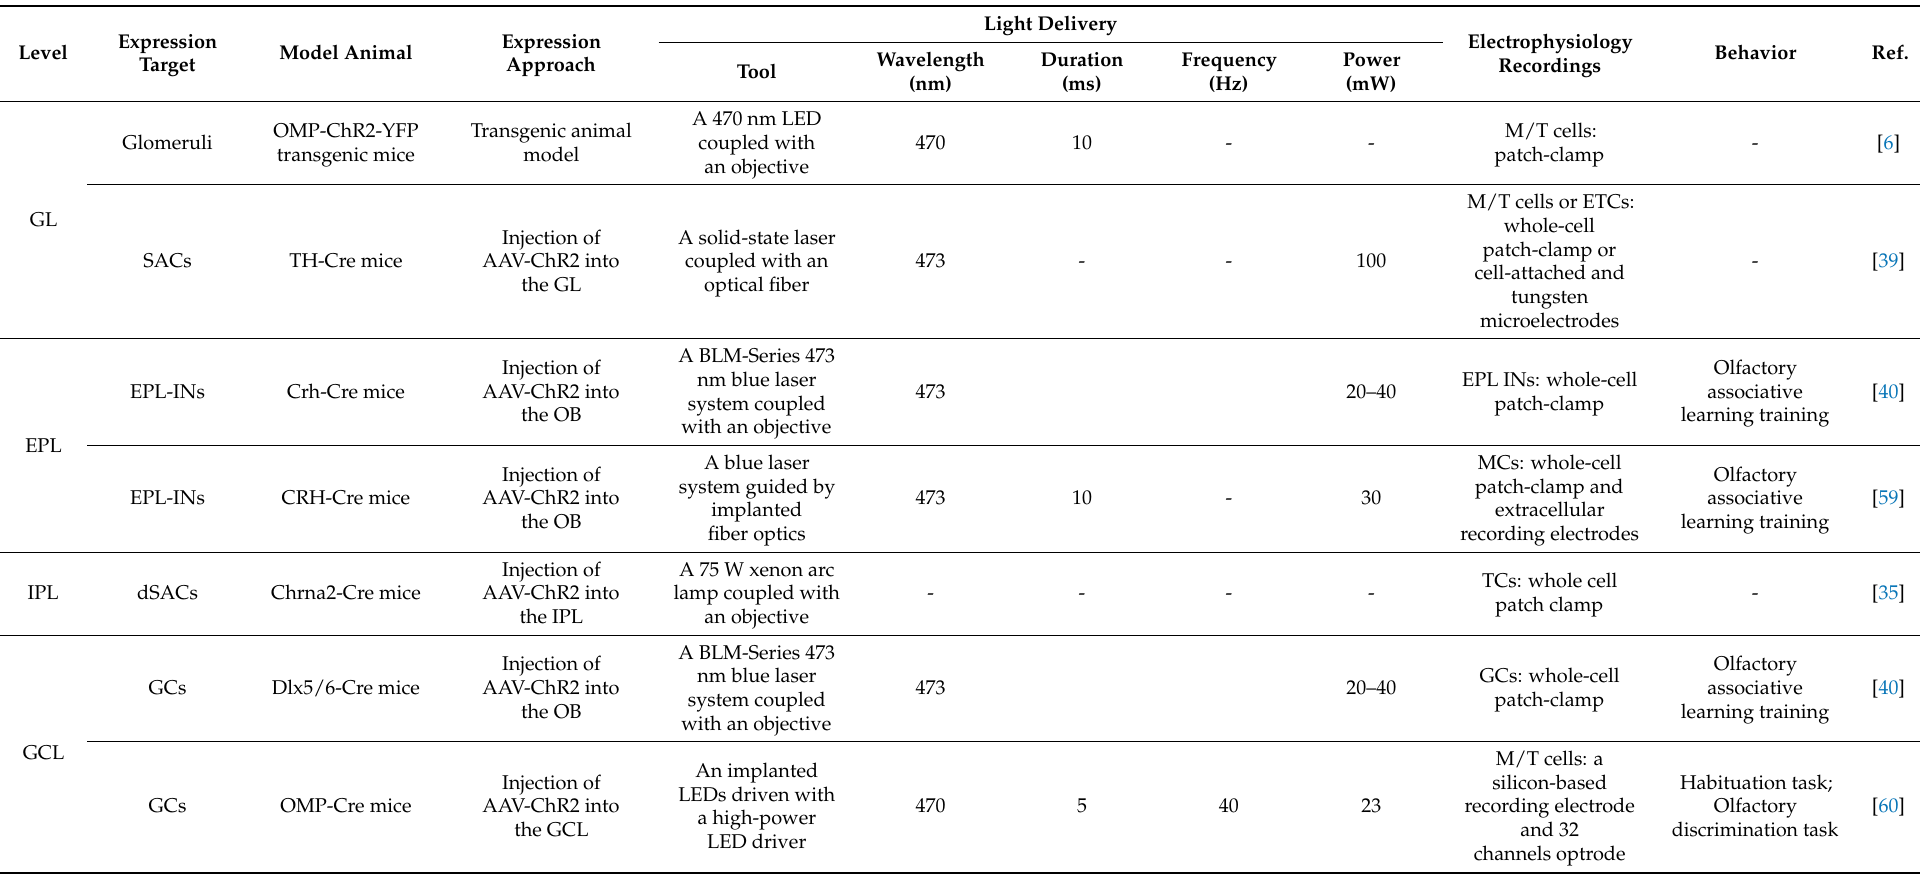
Table 1. Optogenetics approach in interneurons in